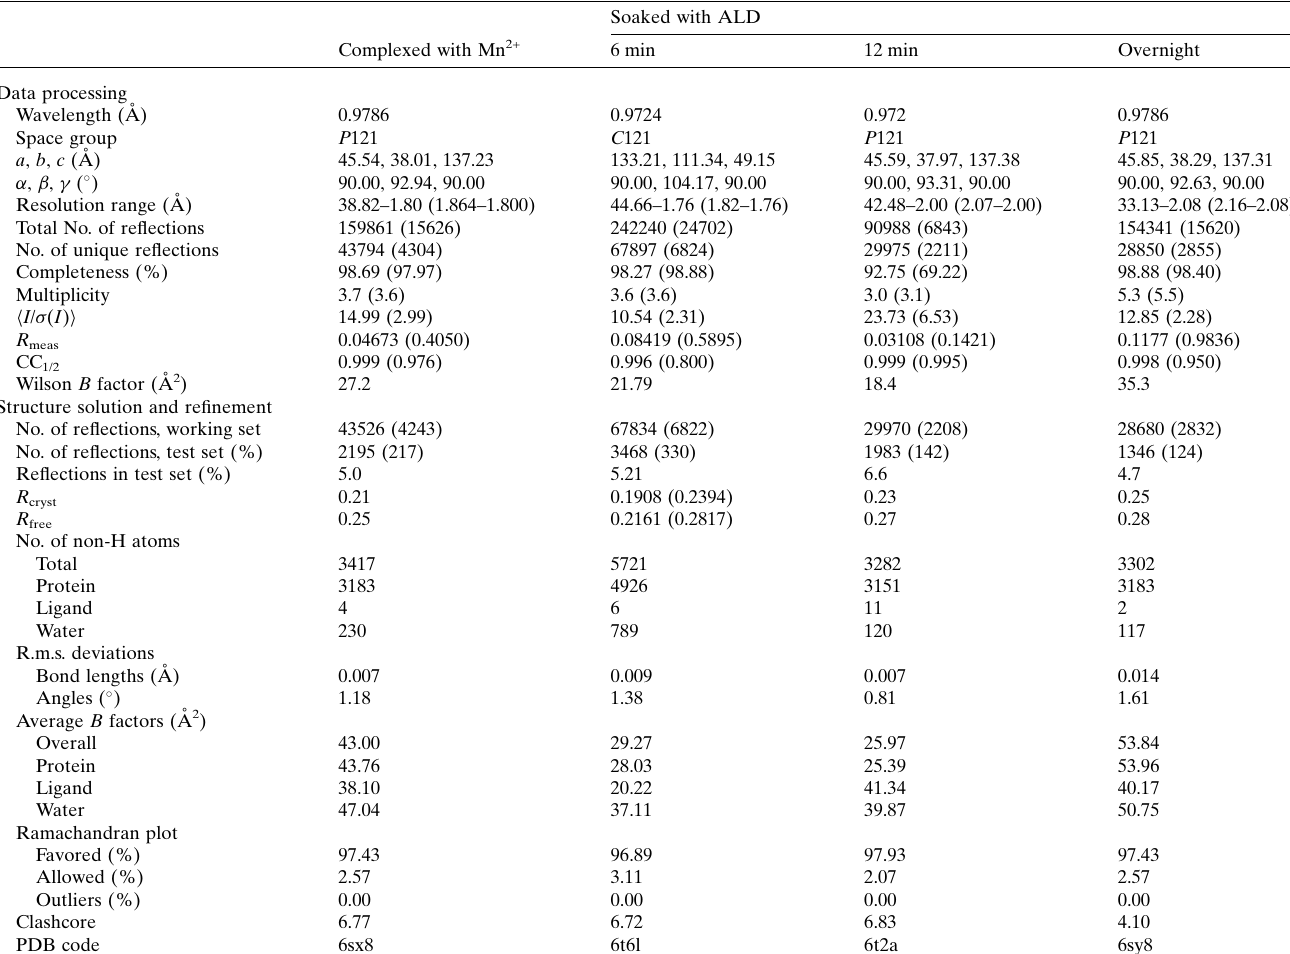
Table 1 Data processing, structure solution and refinement of MOPV NP-exo. Values in parentheses are for the highest resolution